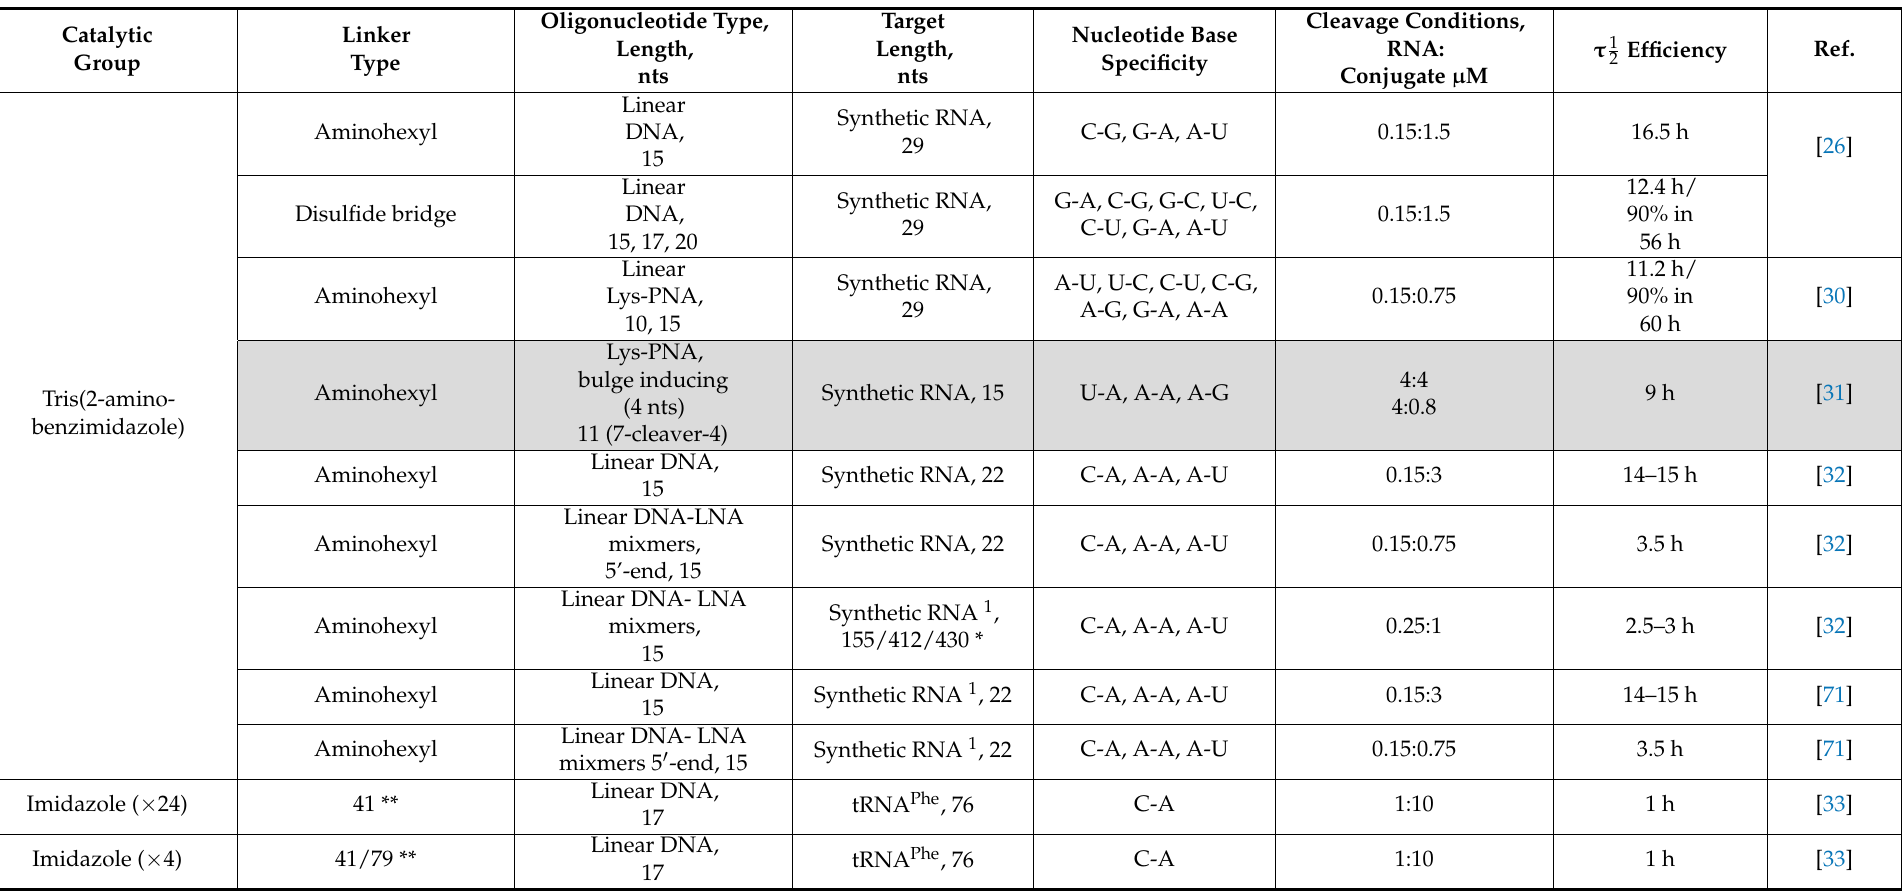
Table 1. Design and catalytic performance of established